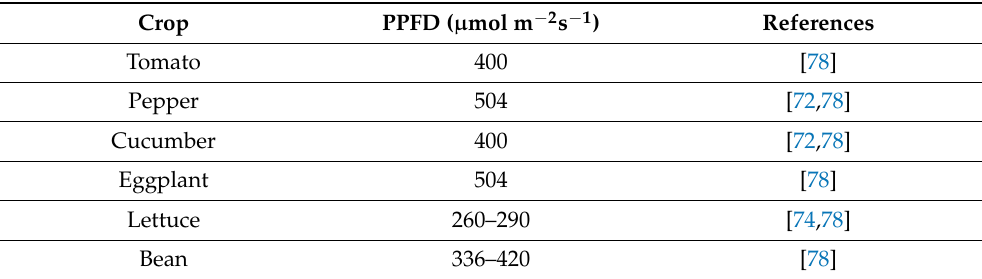
Table 4. PPFD requirement for selected greenhouse crops grown used in arid regions.